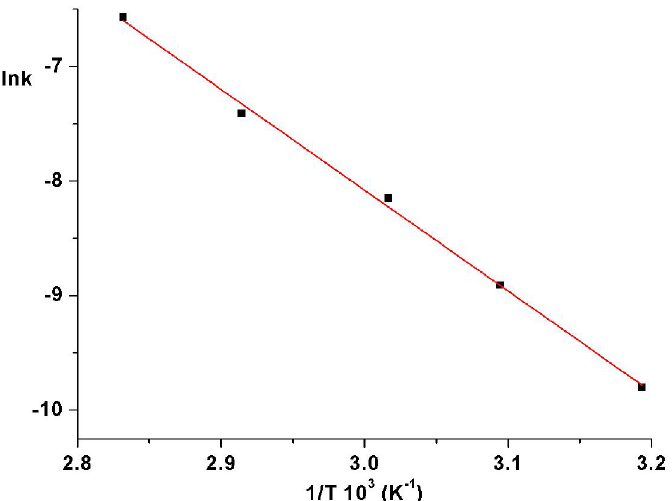
Figure 10. Arrhenius plot for thermal recovery rate constant of azopolymer PTEI in